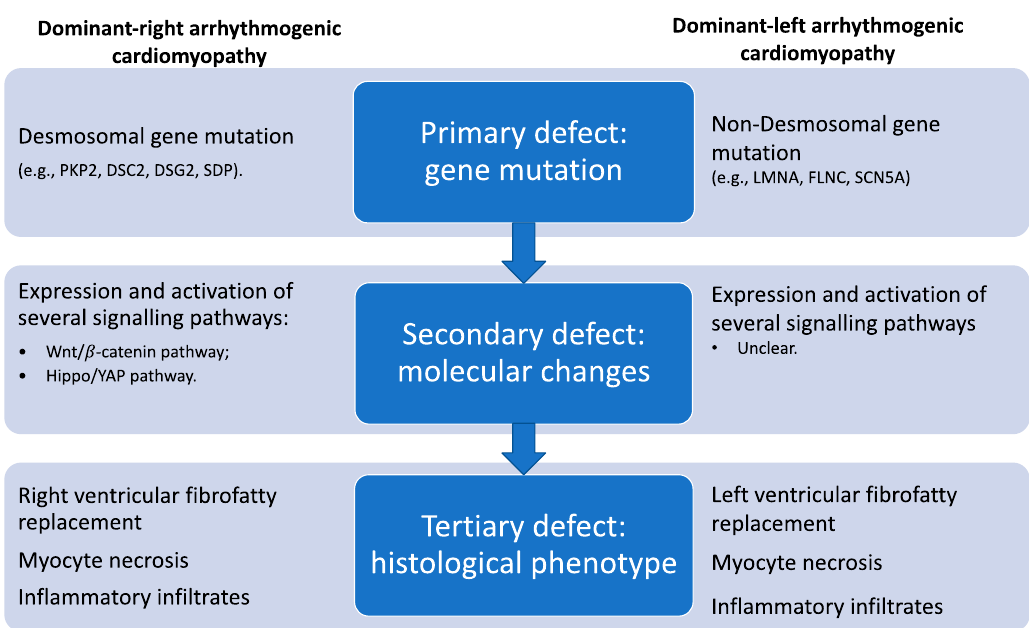
Figure 2. Schematic representation of the pathogenesis of arrhythmogenic cardiomyopathy. See text for details.